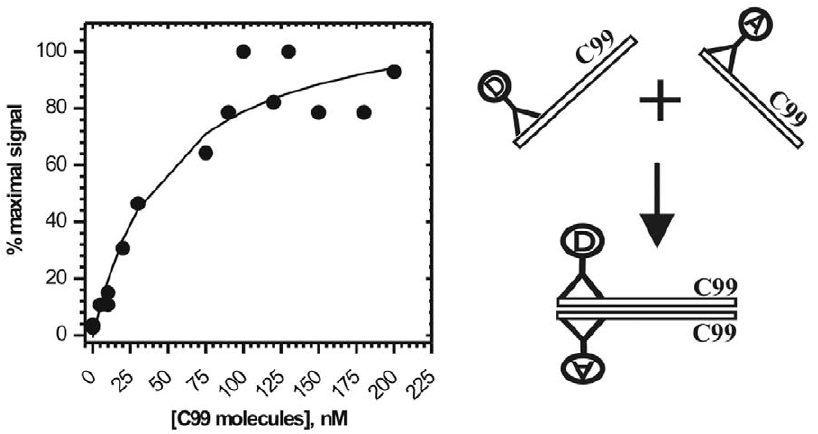
Figure 5. Oligomerization of C99 substrate. C99 dimerization/oligomerization was measured using aliquots of C99 substrate that had high activity with c -secretase in CHAPSO enriched membranes. Oligomerization between C99 molecules was measured using AlphaScreen H technology by coupling both the donor-beads, and the acceptor-beads, to 3D6 antibody (right panel). Increasing concentration of C99 substrate was incubated with 10 nM of 3D6 monoclonal antibodies coupled to either donor or acceptor-beads. Since one epitope can bind only one antibody, the acceptor and the donor beads can come to proximity and give the AlphaScreen H signal only if C99 dimerization/oligomerization brings the epitopes together (right panel). A nonlinear regression and the equation 5 (methods) were used to calculate an apparent dissociation constant, Kd=33 6 2 nM [69].